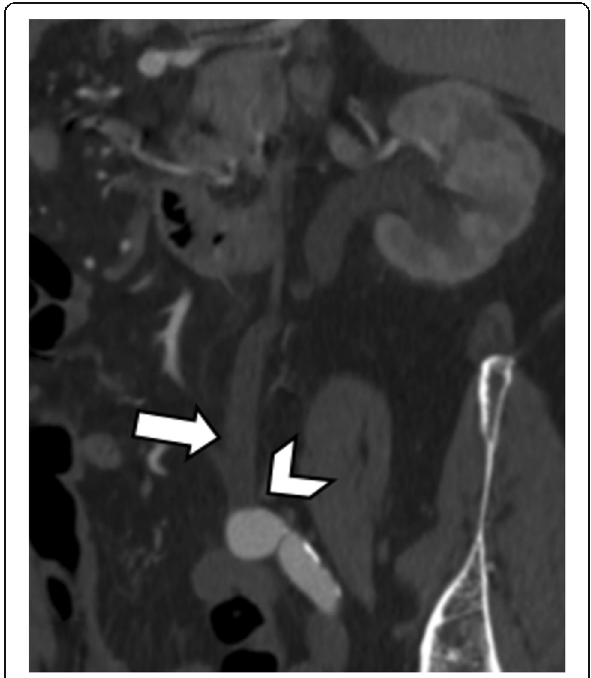
Fig. 16 An 83-year-old man with ureteral vascular compression. Sagittal CT image on arterial phase shows right hydroureteronephrosis (arrow) secondary to compression by a saccular aneurysm (arrowhead) of the adjacent right common iliac artery